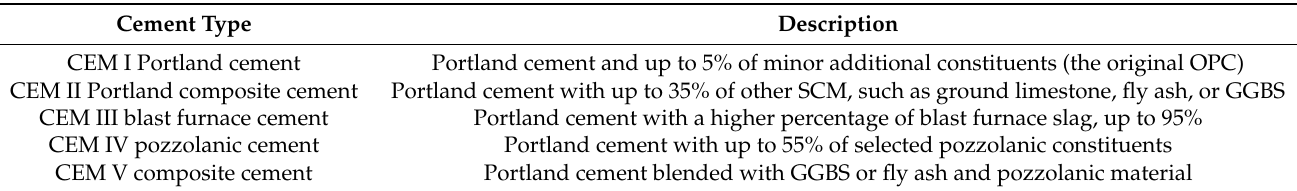
Table 1. Classification of cement types according to cement standard, adapted from [23]. Cement Type